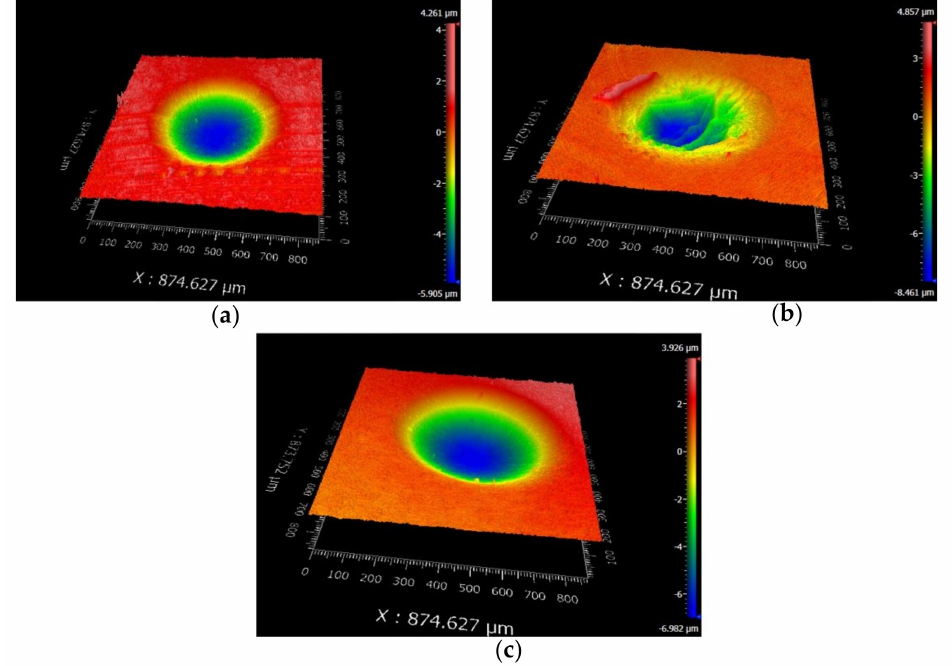
Figure 11. The 3D shape of PVDF thin films with F n = 15 N, ƒ = 15 Hz, and V c = 0 V: ( a ) D = ± 5 µ m, ( b ) D = ± 15 µ m, and ( c ) D = ± 40 µ